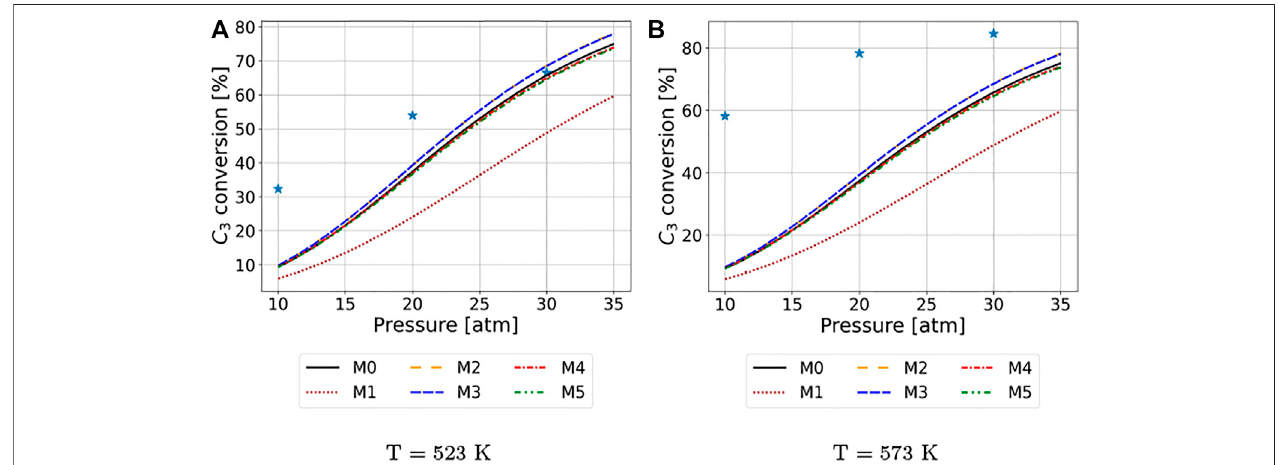
FIGURE5| Propylene conversion from M0 to M5 withrespect topressure at constantspacevelocity (1123 mol − feedmol − H +− 1 min − 1 )and temperatures 523 K (A) and 573 K (B) . The blue stars represent the MK model simulation data. The solid and dashed lines represent the reparameterized ROK model simulations. The lines for models M2 and M3 overlap each other and the lines for models M0 , M4 , and M5 overlap each other.